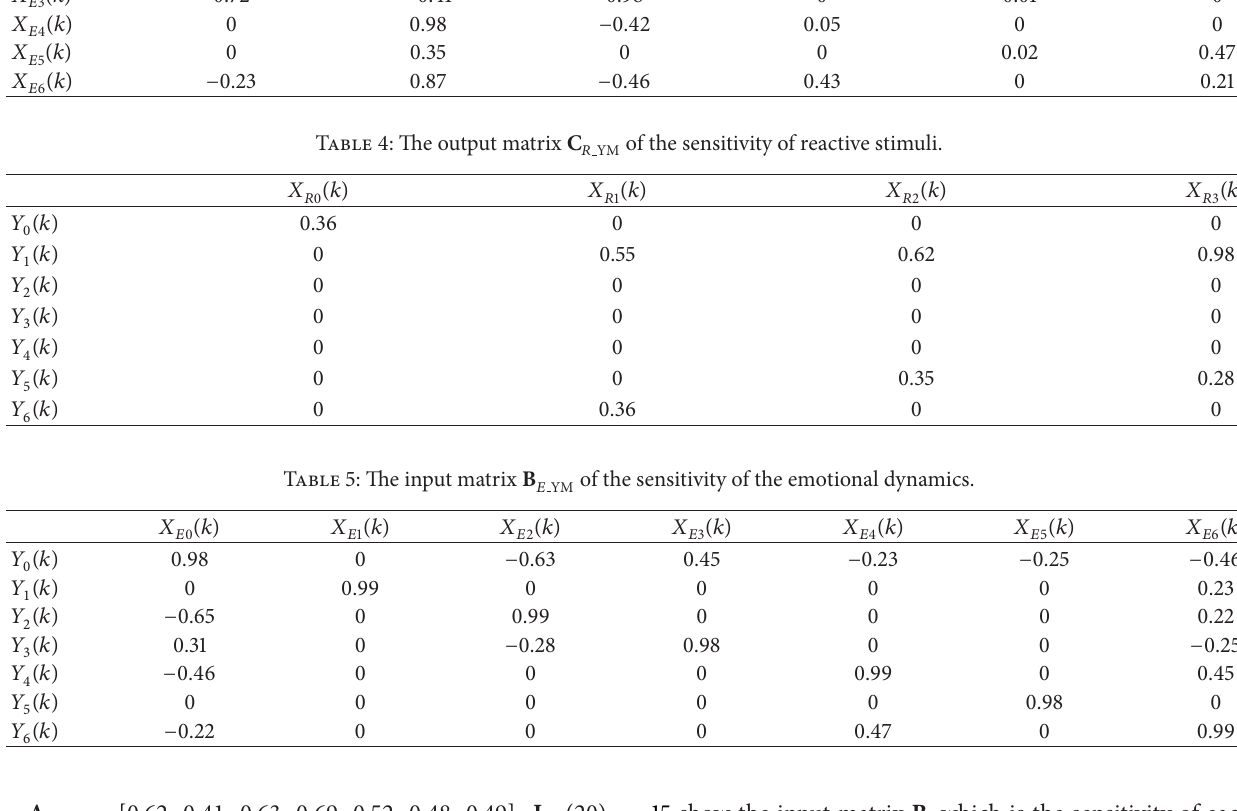
Table 4: The output matrix C 𝑅